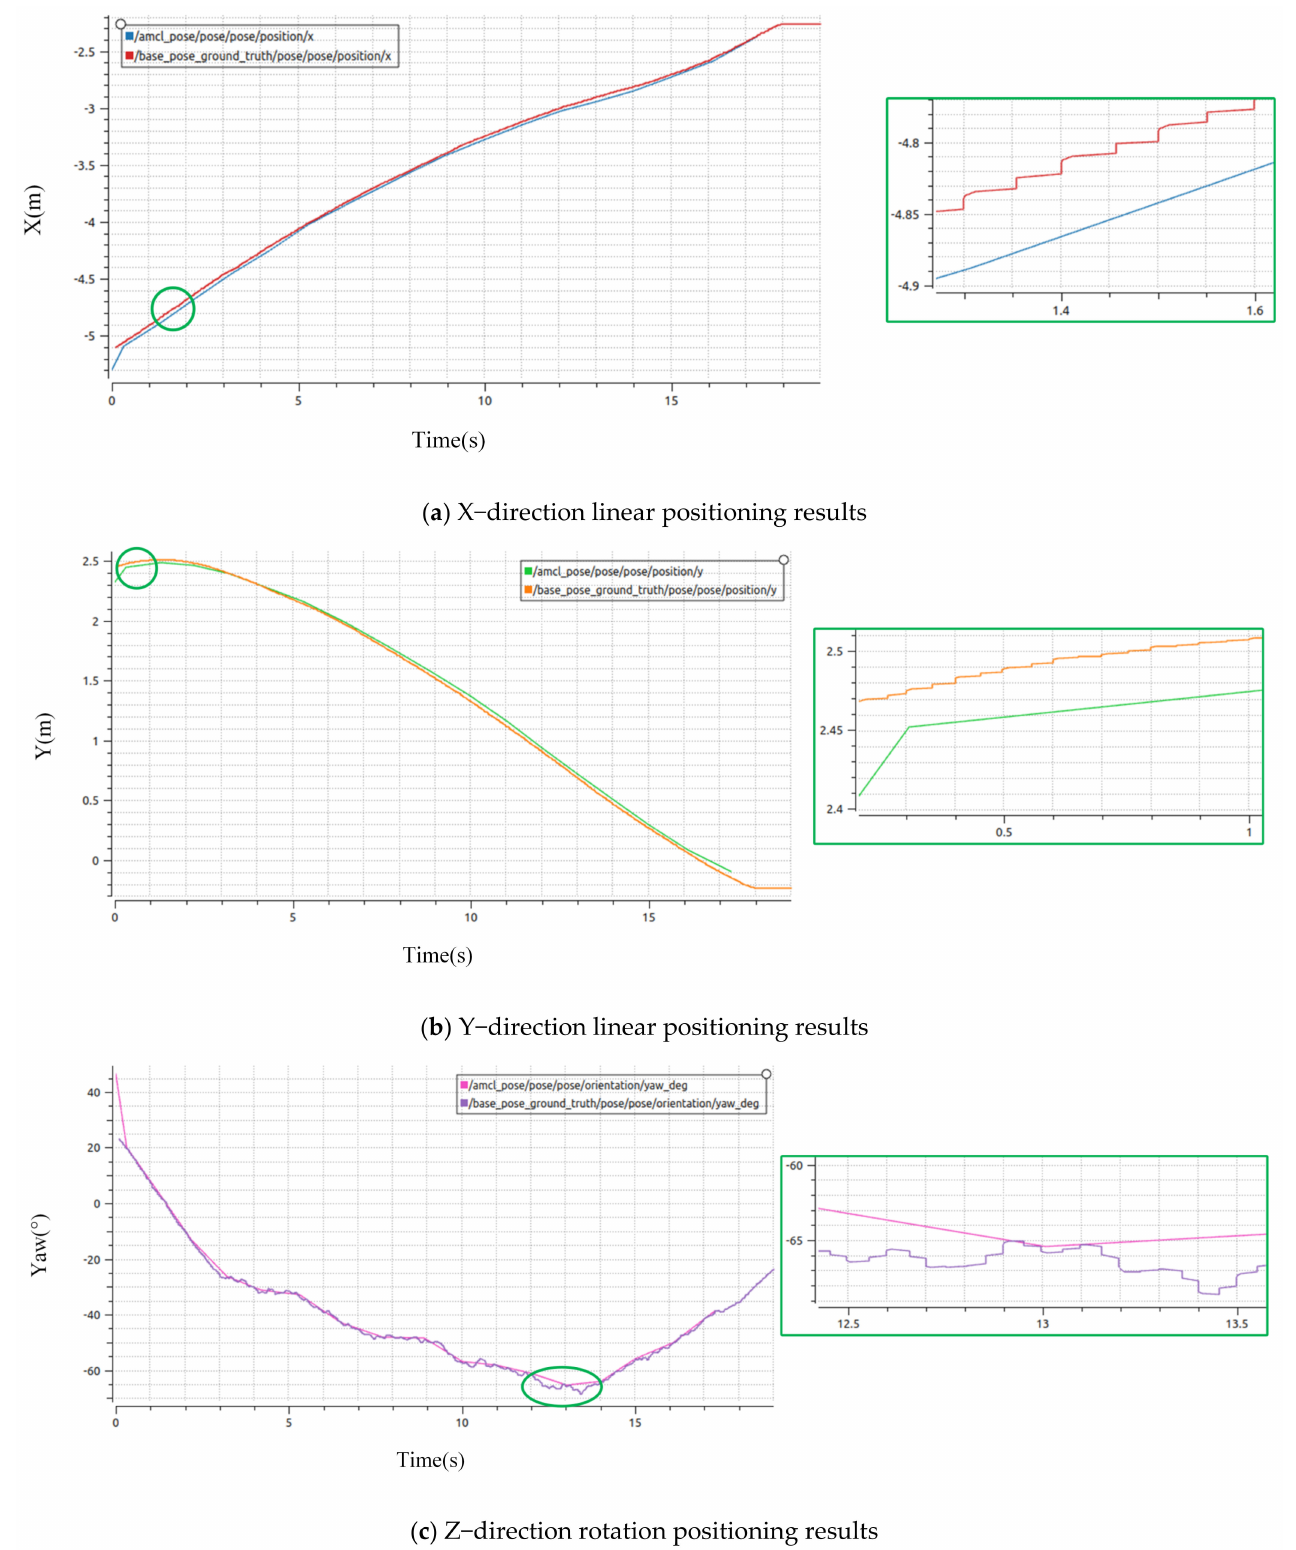
Figure 6. Results of the first group of AMCL simulation positioning